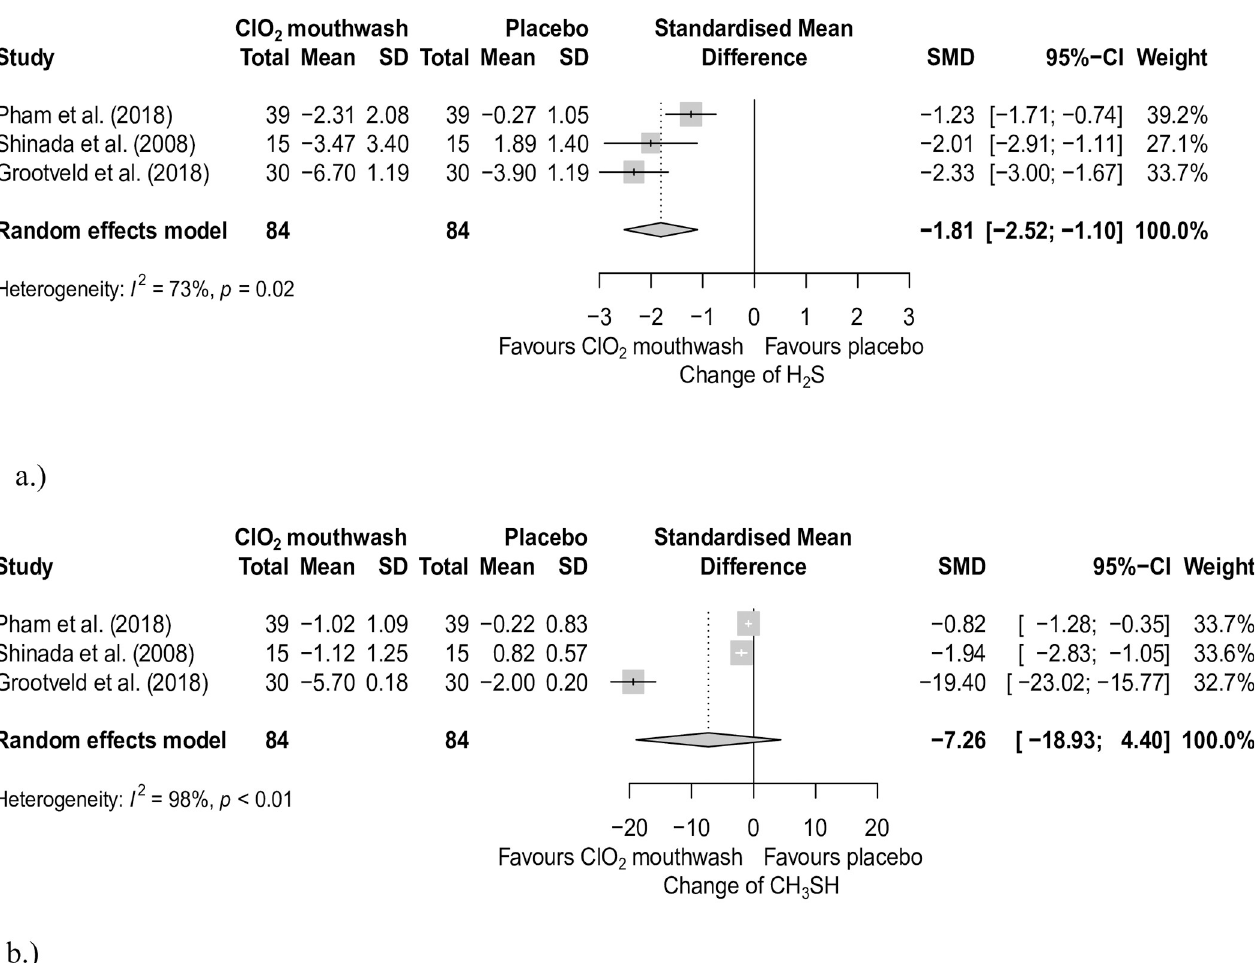
Fig 3. a. Forest plot analysis of the changes of hydrogen sulfide concentration between baseline and within one day with and without ClO 2 mouthwash. b. Forest plot analysis of the changes of methyl mercaptan within concentration between baseline and one day with and without ClO 2 mouthwash. SMD: Standardized mean difference; CI: Confidence interval; SD: Standard deviation; ClO 2 : chlorine